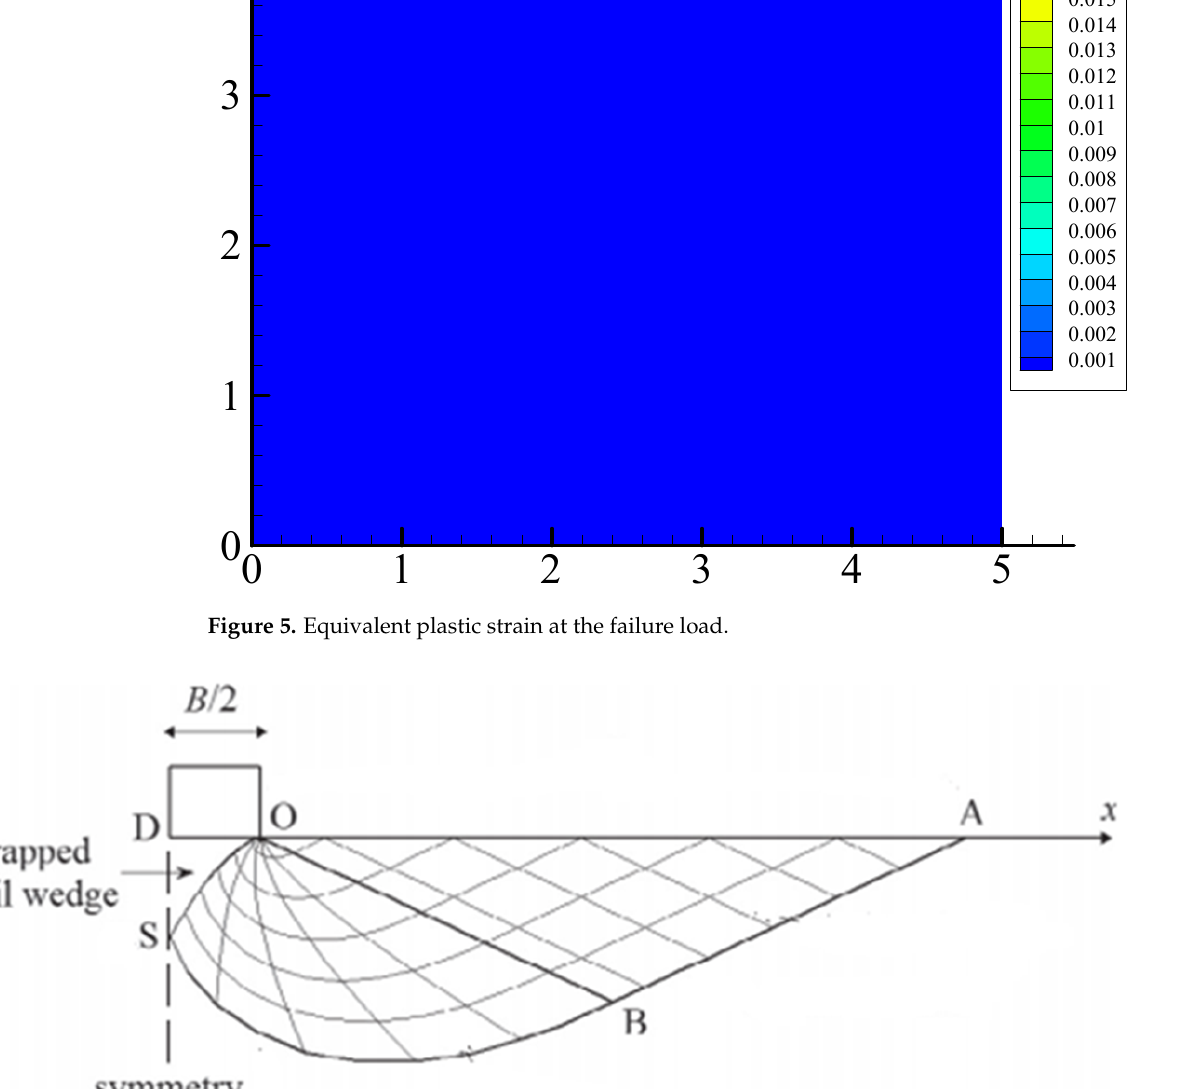
Figure 6. Slip-line field of strip